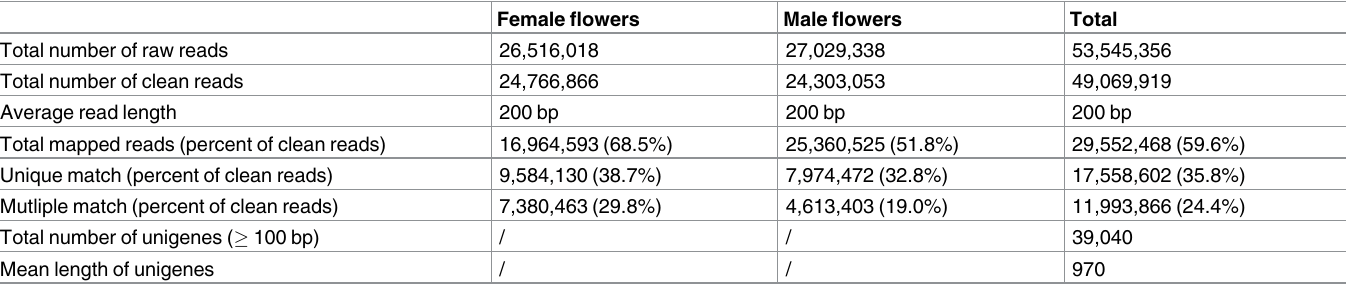
Table 1. Summaryof sequence